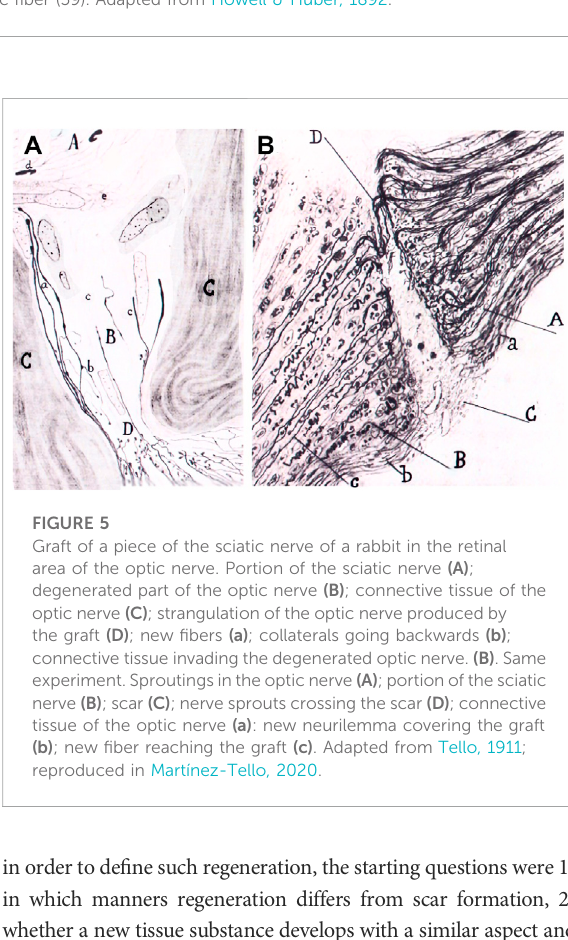
FIGURE 3 Microscopicobservationsfromaregeneratednerveofadog.Thecentralendofthemediannervewassuturedtotheperipheralendoftheulnar nerve, and long pieces were then removed from the peripheral stump of the median and the central stump of the ulnar, to prevent the possibility of union. Newly formed fi bers were observed (57, 58), as well as an embryonic fi ber (59). Adapted from Howell & Huber, 1892.